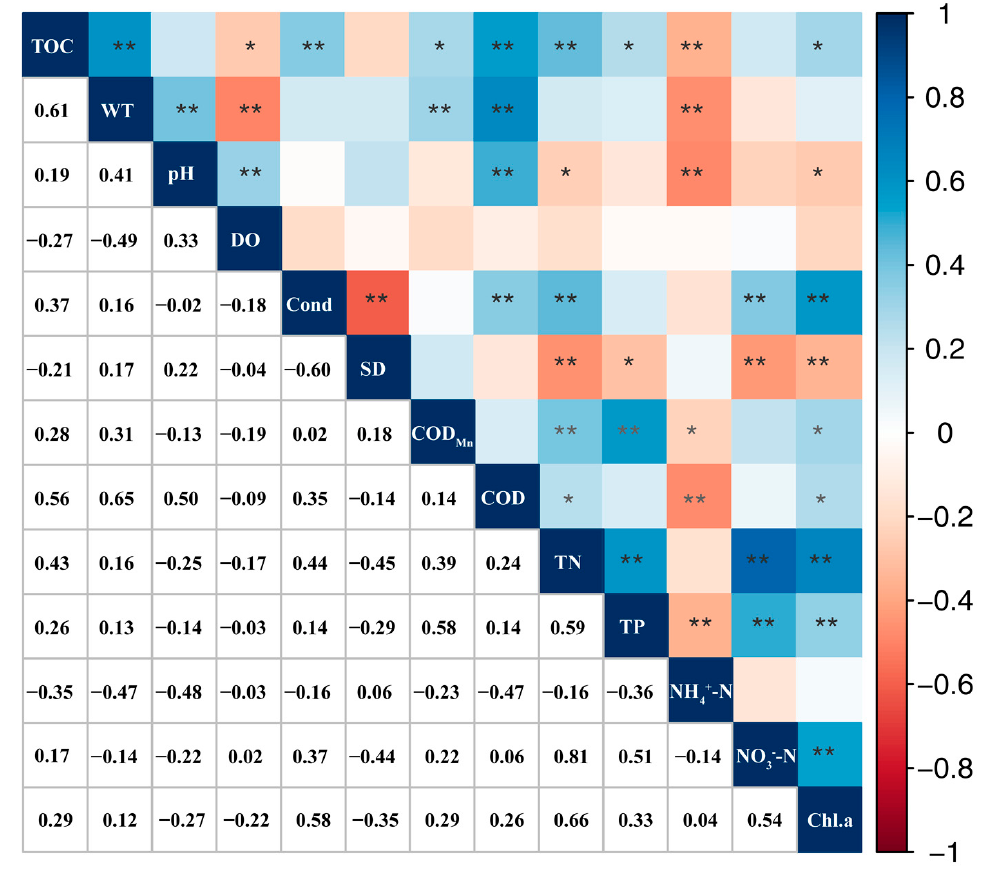
Figure 6. Correlation analysis of TOC concentration and environmental factors in the Danjiangkou Reservoir.